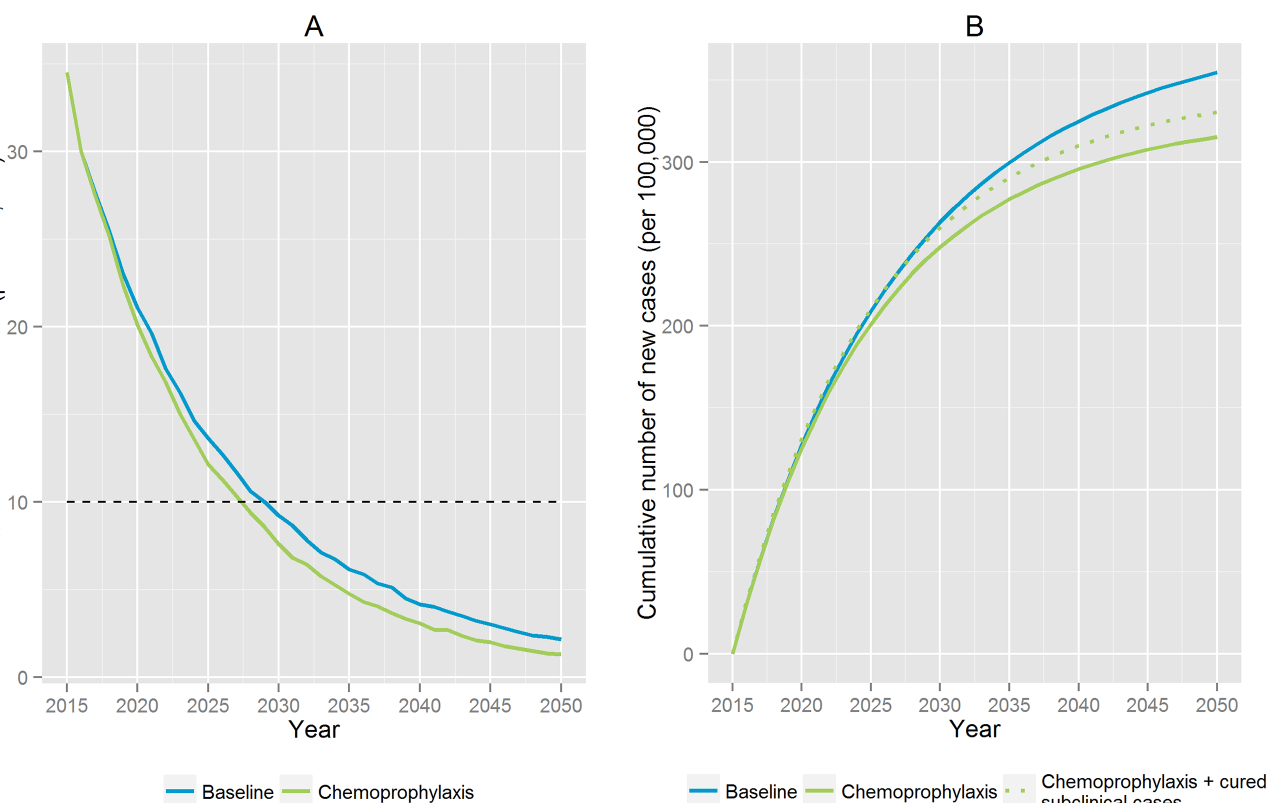
Fig 3. Impact of chemoprophylaxis on the new case detection rates of leprosy in Pará State, Brazil. A) Predicted decline of the new case detection rates with chemoprophylaxis since start of the intervention. B) Cumulative new cases detected (per 100,000 person population) since start of the intervention. Results are an average of 100